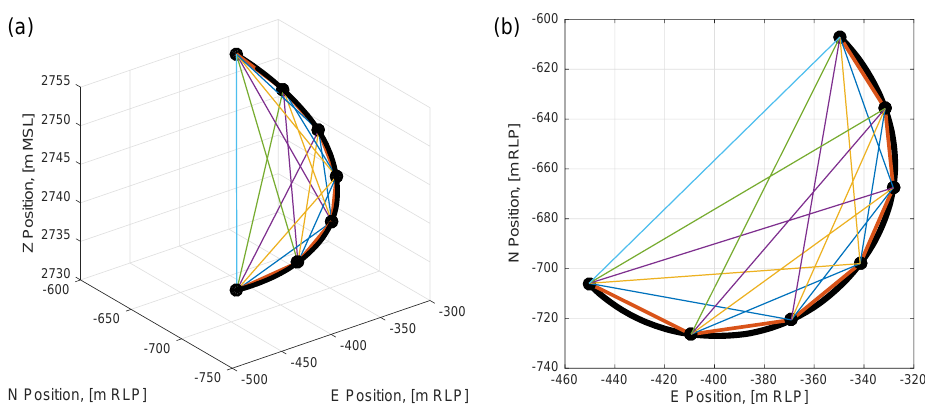
Figure 8. Illustration of a method for evaluating C 2 n (adapted from Wainwright et al., 2015; Bonin et al., 2015) for a helical trajectory. The different distances δ E are represented by the lines with different colors. The measured points are indicated by the black dots. The smallest distance used in the DH direct method is indicated by the thick red line. (a) 3-D view of the trajectory for a portion that covers at least one half circle. (b) Top view of the trajectory.